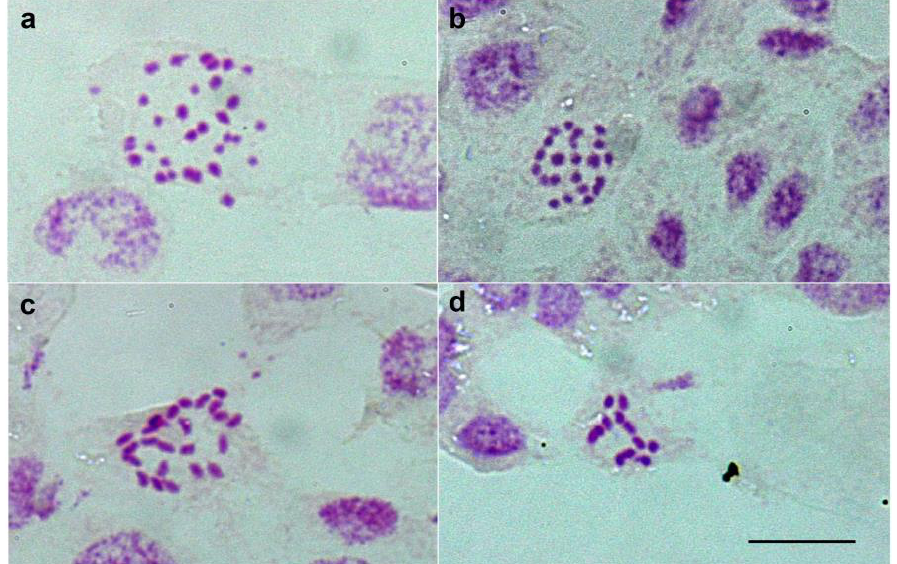
Figure 1. Metaphase or pro-metaphase chromosomes of ( a ) Luzula alpina (2 n = 4 x = 12 AL + 24 BL; location 12, individuum 106), ( b ) L. exspectata (2 n = 2 x = 24 BL; loc. 1, ind. 15808-105/7), ( c ) L. multiflora (2 n = 4 x = 24 AL; loc. 17, ind. 323) and ( d ) L. taurica (2 n = 2 x = 12 AL; loc. 28, ind. 15779-1). The bar represents 10 μm. Location numbers and individuum numbers correspond to Table S1.